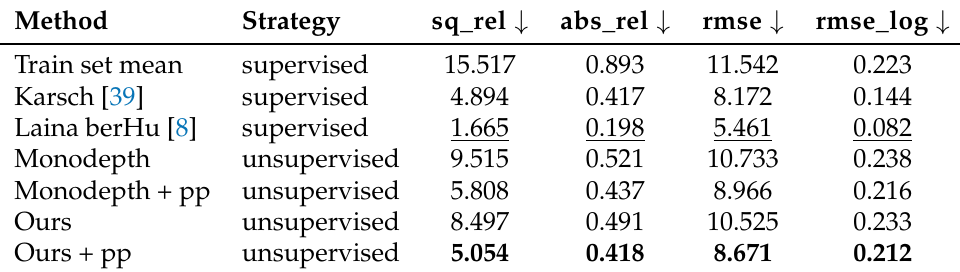
Table 4. Results on the Make3D dataset [38]. Losses are calculated on the cropped central images and the depth is lower than 70 m.